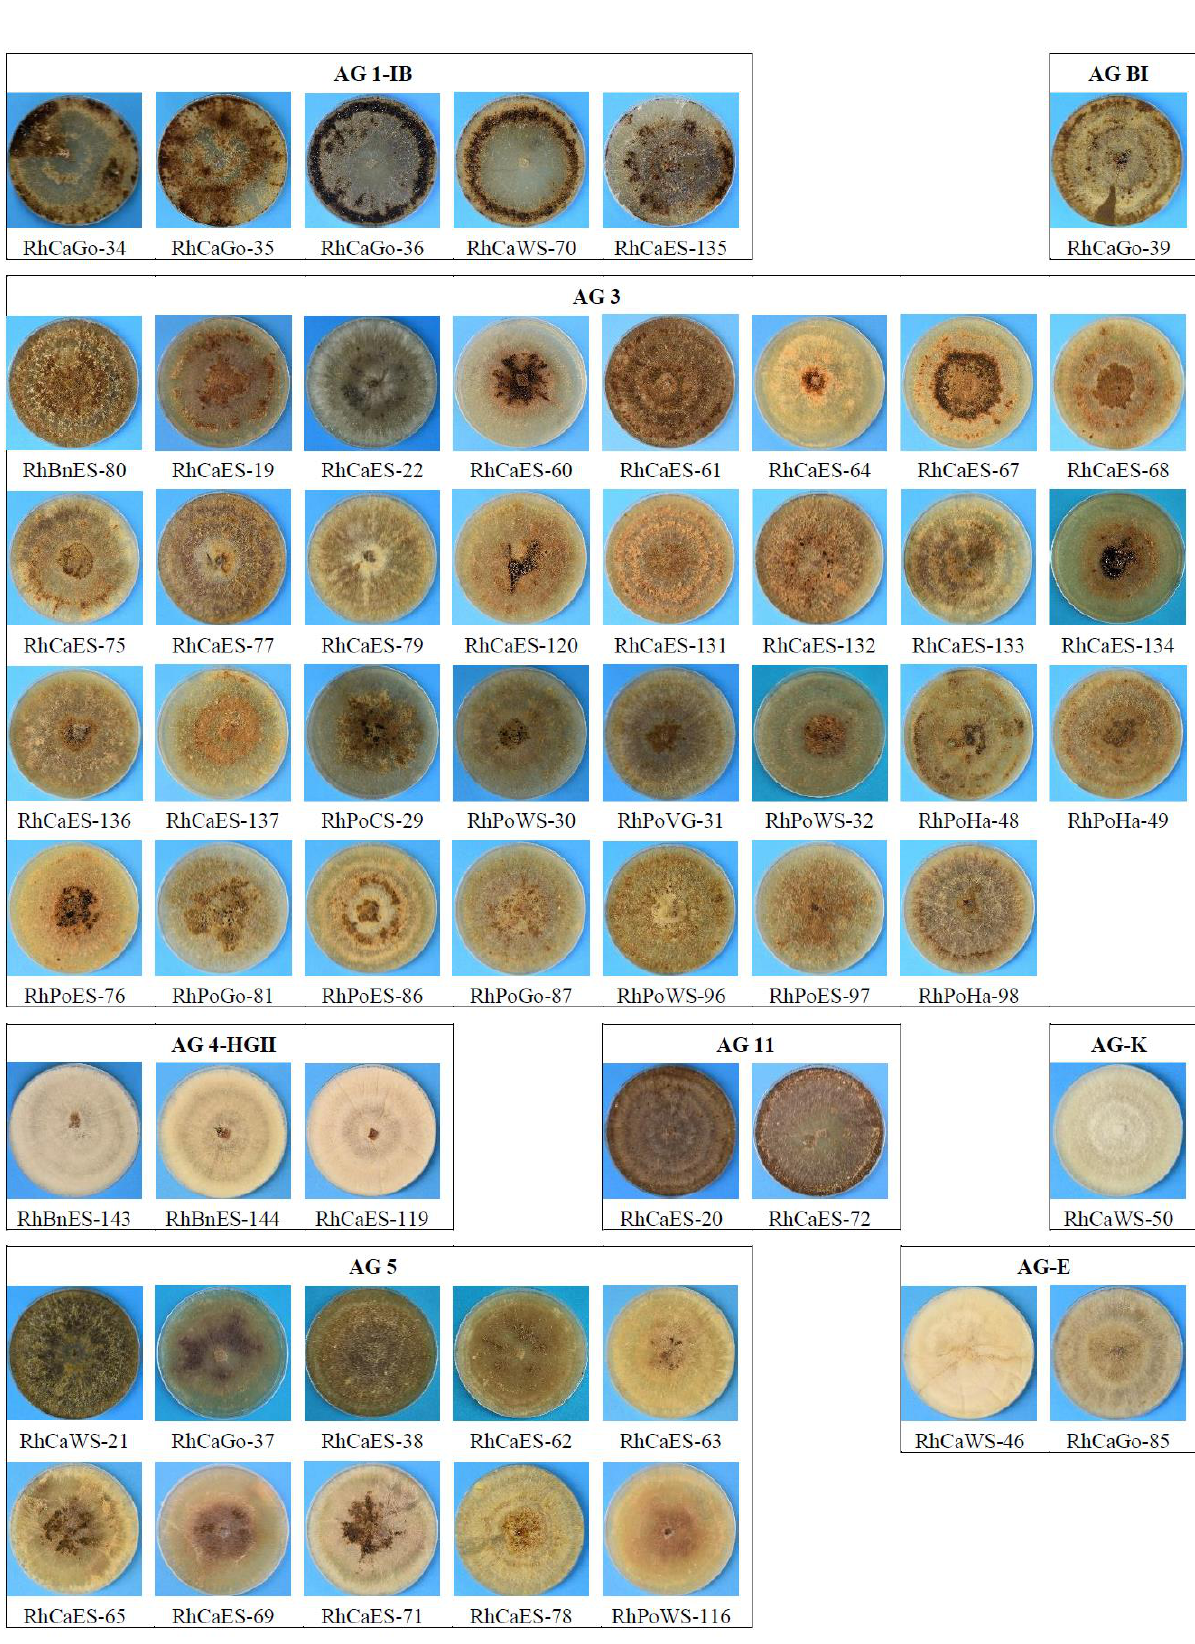
Figure 5. Colony morphology on PDA of different anastomosis groups: AG 1-IB, AG 3, AG 4-HGII, AG 5, AG 11, AG BI, AG-E and AG-K. Mycelium was 14 days old and incubated at room temperature.